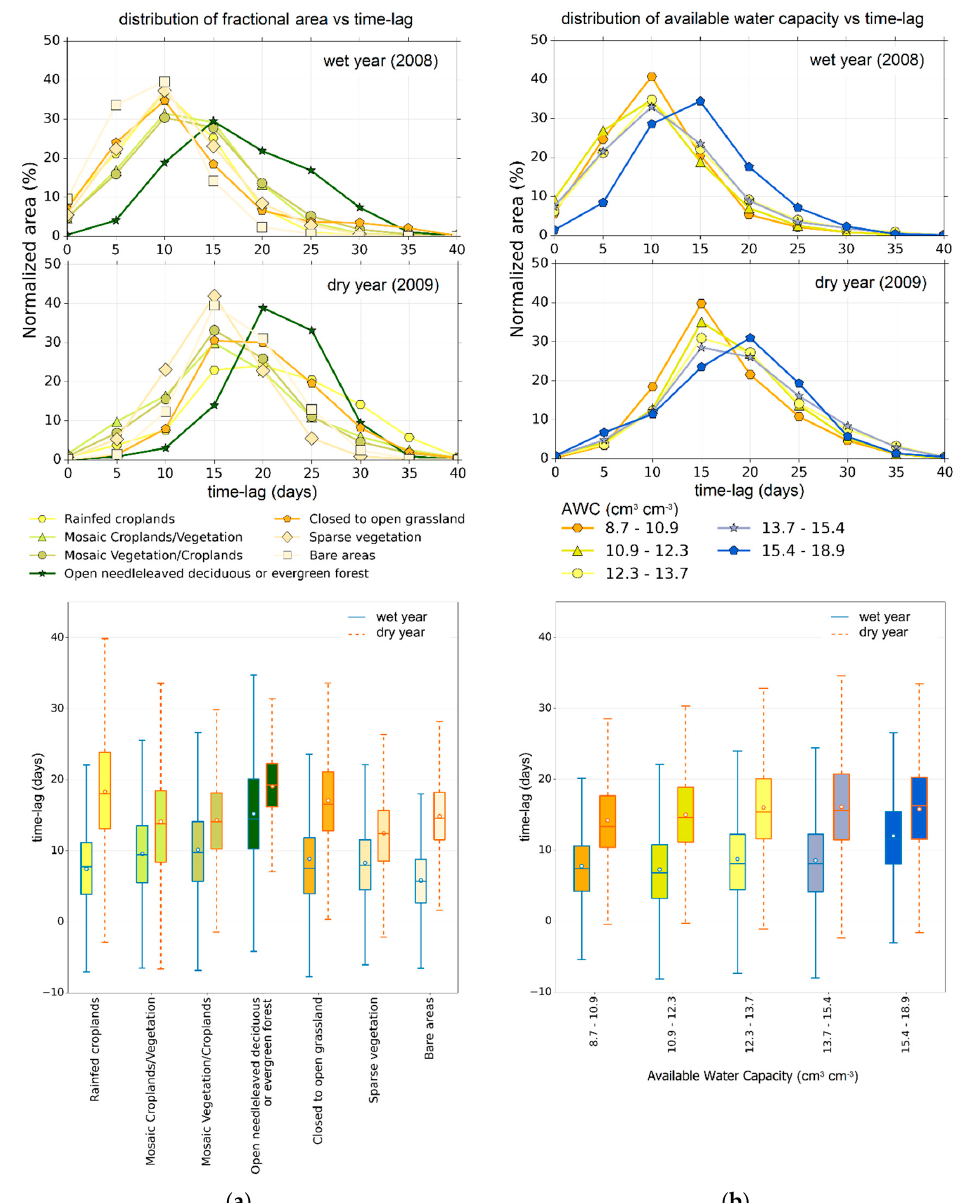
Figure 10. Top panels: Distributions of the time lag in days in the dry and wet years stratified by land cover classes ( a ) and available water capacity ( b ). Bottom panels: Box plots of the time lag.